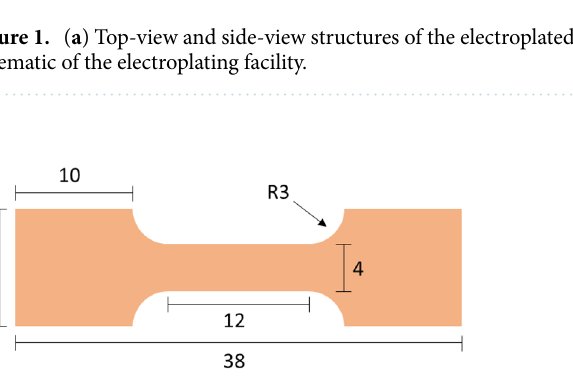
Figure 2. Dimension of the dog-bone shaped electroplated Cu for the tensile tests (unit: